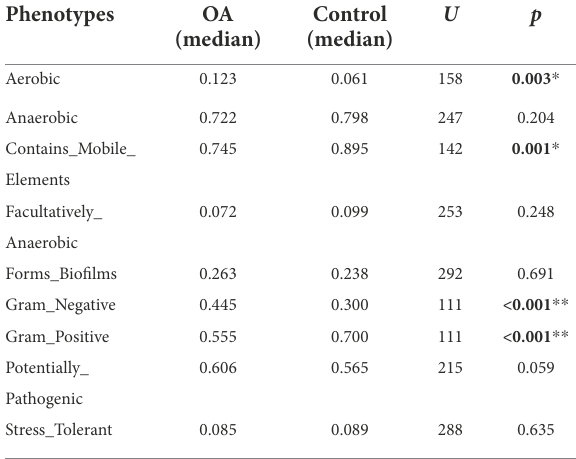
TABLE 6 The relative abundance of phenotypes between